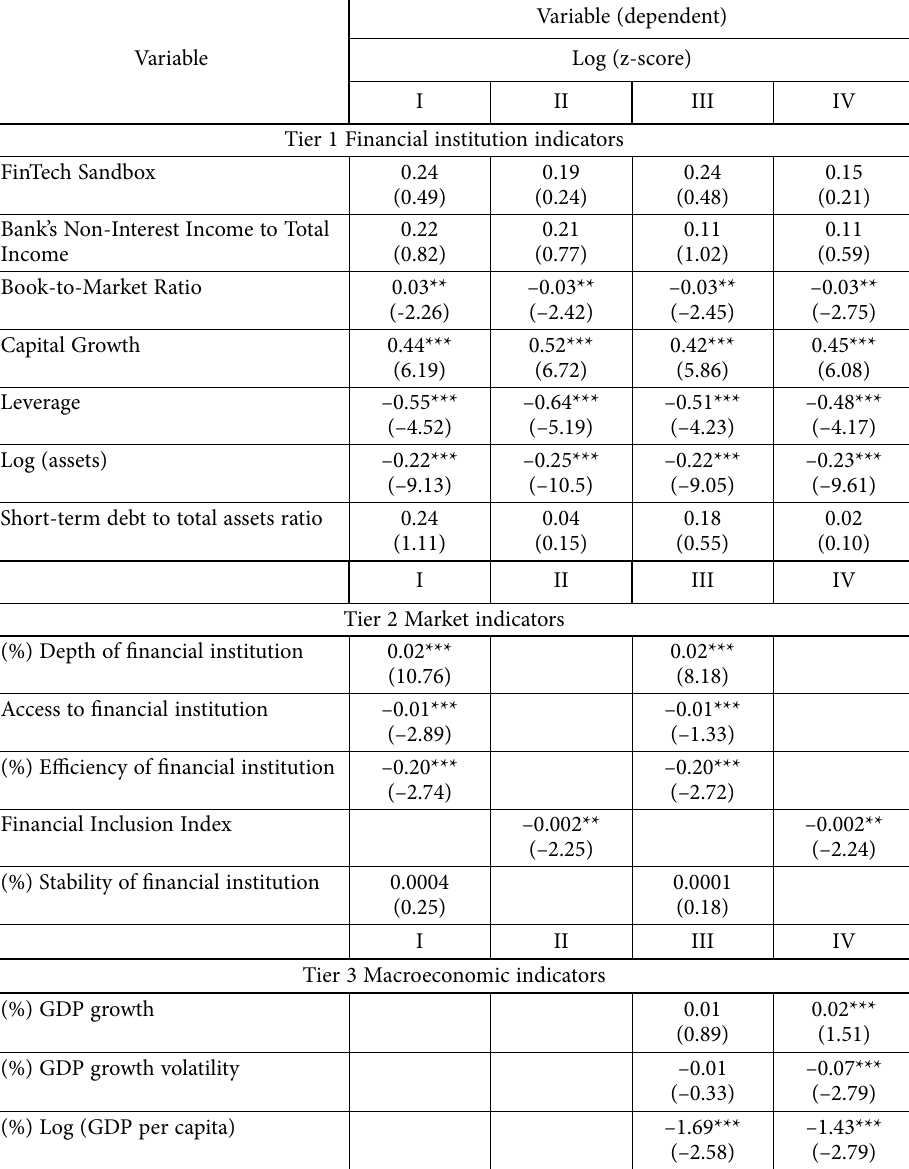
Table 3. FinTech sandboxes introducing internal impact (regression of